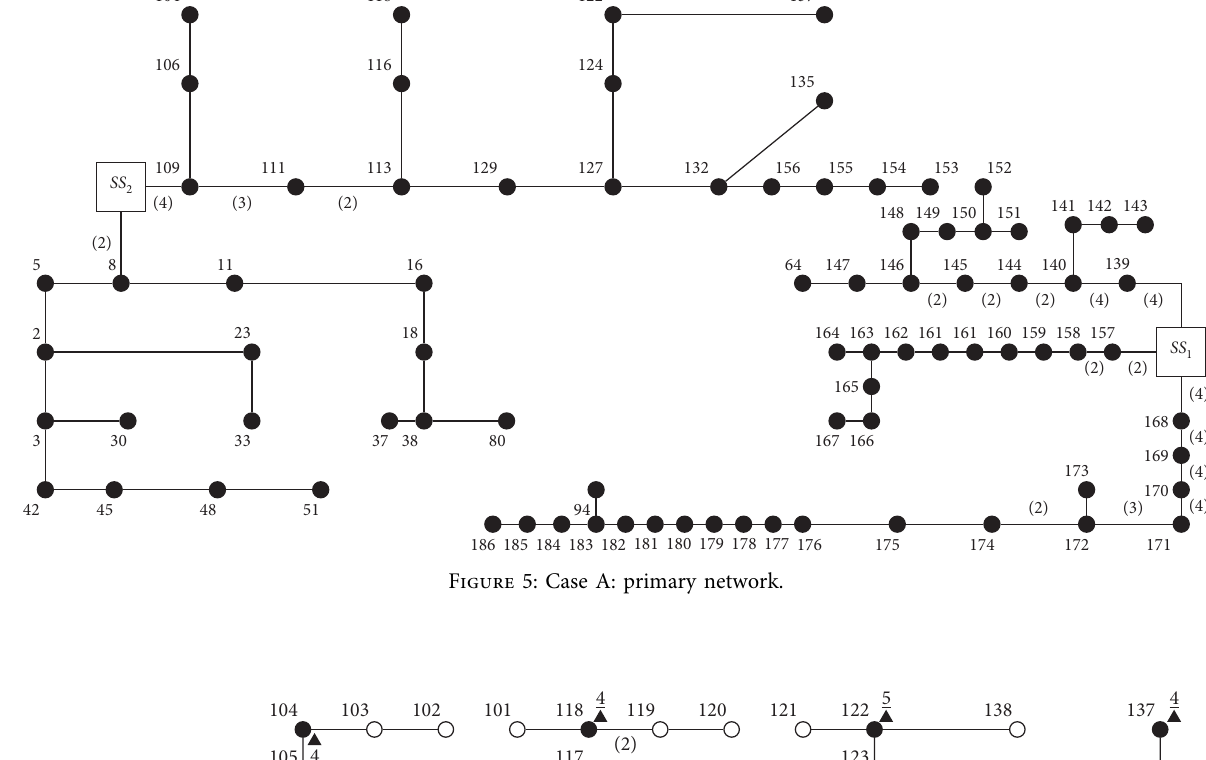
Figure 5: Case A: primary network.